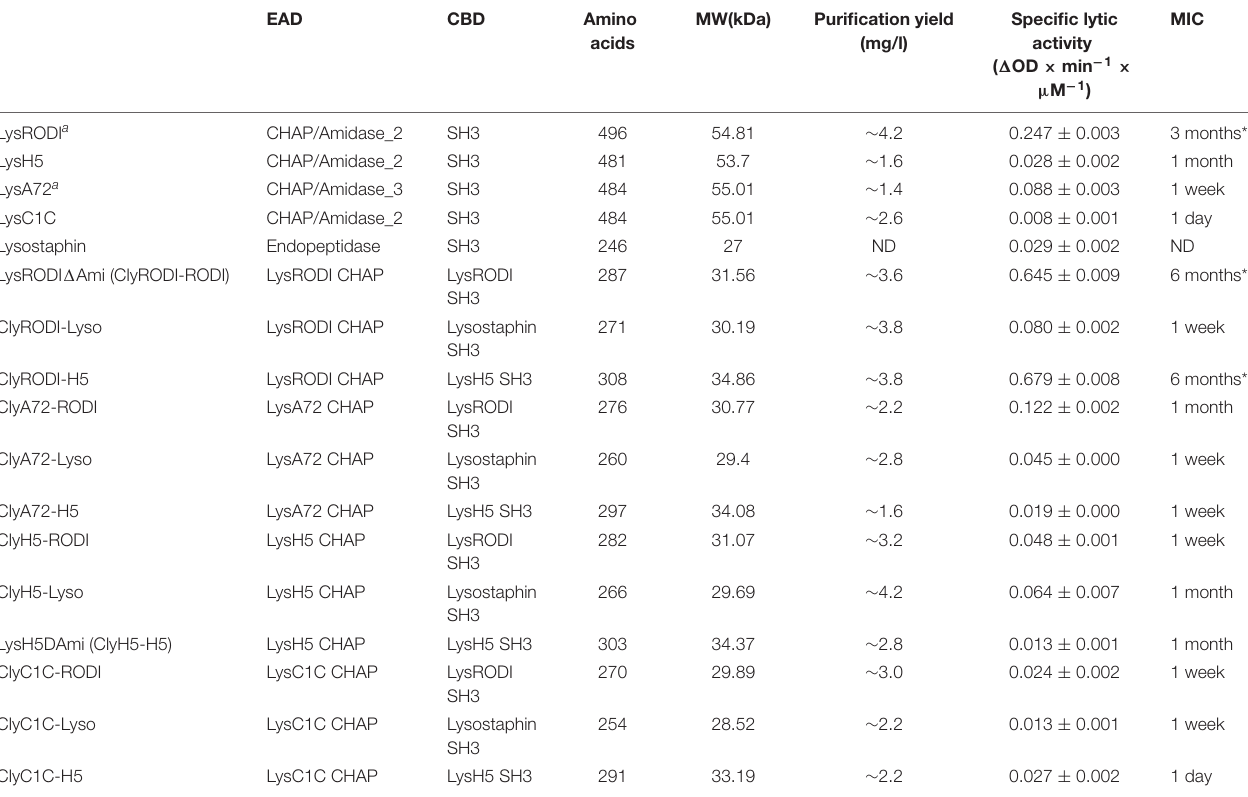
TABLE 2 | Principal characteristics and shelf-life storage of the engineered lytic proteins obtained in this work. EAD CBD Amino MW(kDa) Purification yield acids